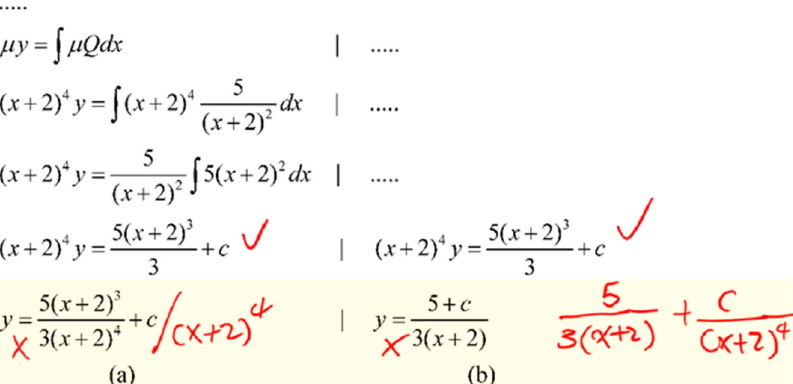
Figure 3. Reproduced examples of incorrect solutions to Example 2 using Formula (14). ( a ) c should be divided by ( x + 2) 4 too; ( b ) c and 5 should not share the same denominator 3( x + 2).